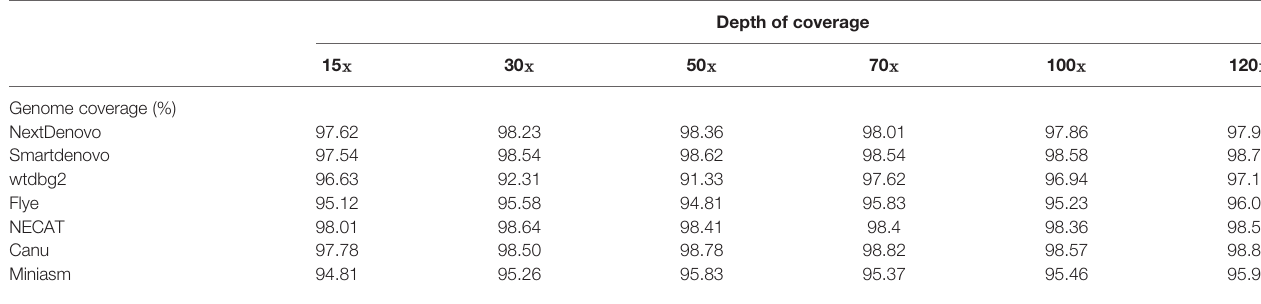
TABLE 3 | Genome coverage percentages of assemblies from different sequencing depths.